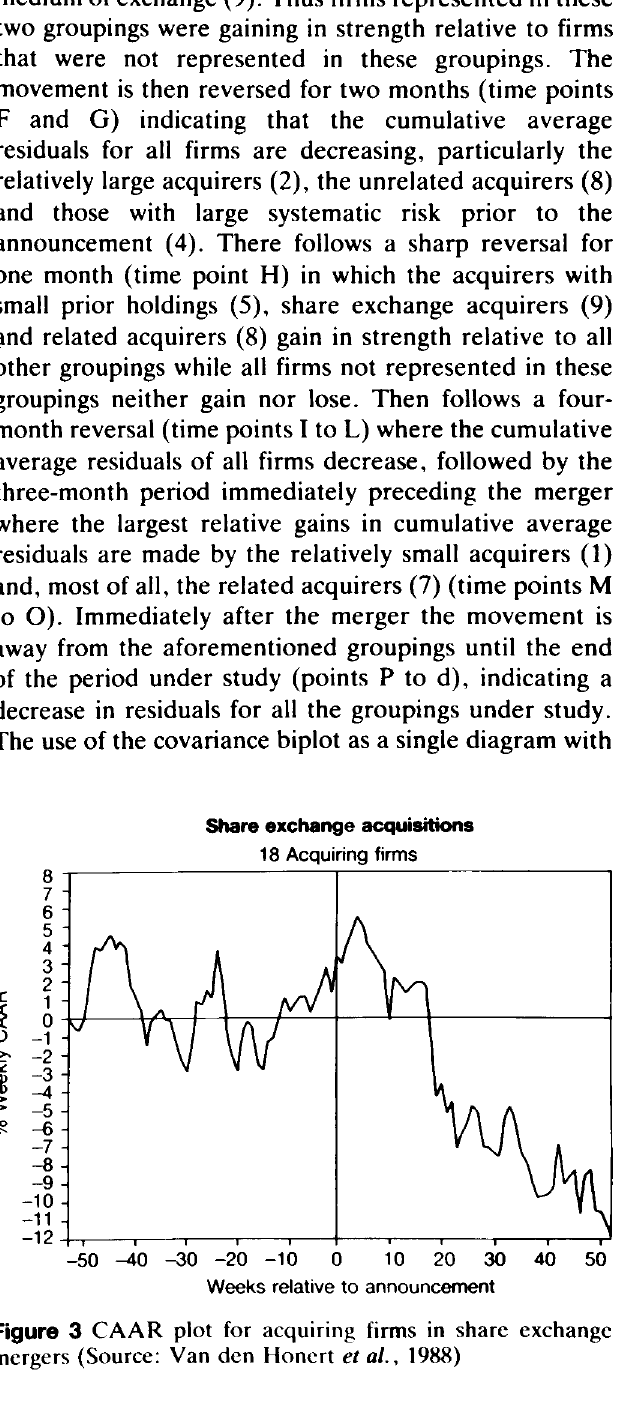
Figure 3 CAAR plot for acquiring firms in share exchange mergers (Source: Van den Honcrt et al.,